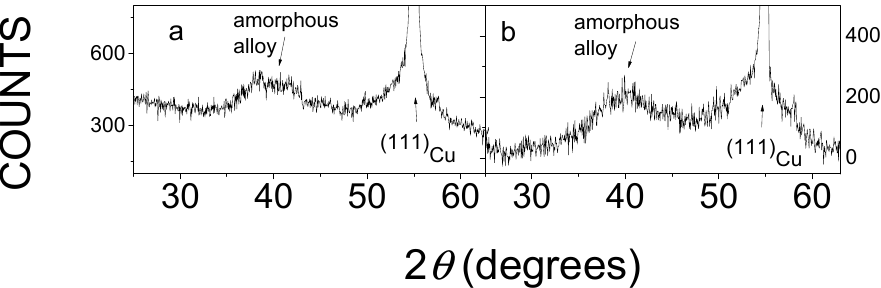
Figure 5. DetailsofXRDpatternsoftheDC3( a )andPP3( b )electrodepositedquaternarySn-Fe-Ni-Co Figure 5. Details of XRD patterns of the DC3 ( a ) and PP3 ( b ) electrodeposited quaternary Sn-Fe-Ni- Co alloys.